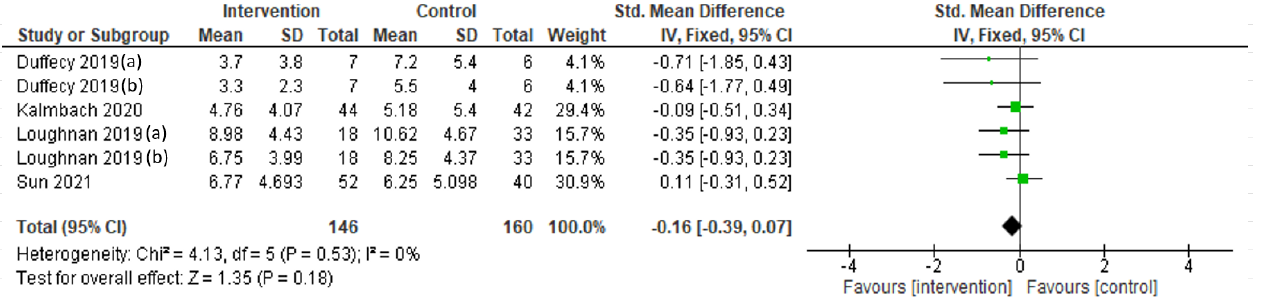
Figure 3. Depression symptoms at the 6-month postpartum follow-up: Duffecy 2019 (a, [64]) = PHQ-9; Duffecy 2019 (b, [64]) = HARS; Loughnan 2019 (a, [67]) = EPDS; Loughnan 2019 (b, [67]) = PHQ-9.